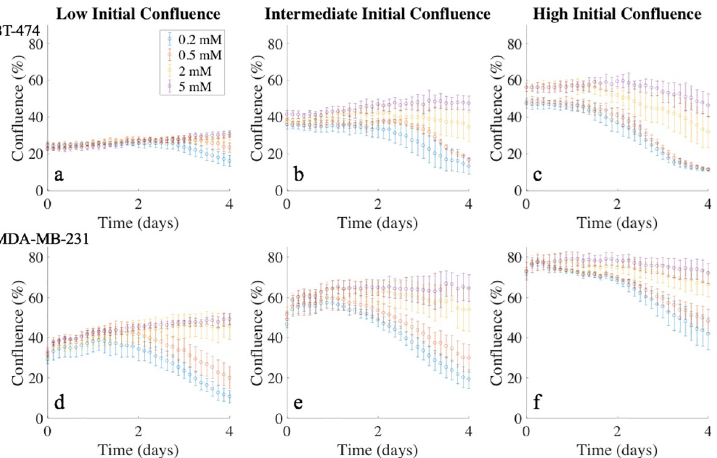
Fig 2. Time courses of tumor cell confluence in media with varying initial glucose levels, grouped by initial confluence. Panels a-c present confluence time courses for the BT-474 cell line, while panels d-f present confluence time courses for the MDA-MB-231 cell line. Different colors represent the four initial glucose concentrations, and the error bars were calculated from four replicates with similar initial conditions. In each panel, cells represented by each color were seeded at the same initial confluence, but yielded significant differences in confluence at the end of the experiment. These time courses provide quantitative and dynamic data on the effects of glucose availability and confluence on tumor cell growth.